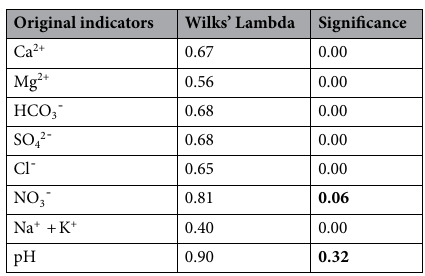
Table 2. Equivalence test of group means. Significant values are in bold.